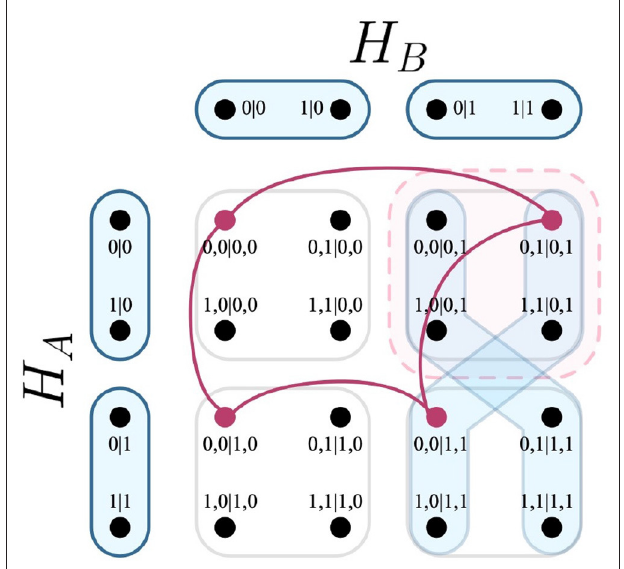
FIGURE 7 | Intersection of a relation, two edges of the F-R product, and a (cid:26) NC C (deep red) intersects one edge of clique. As shown above, the clique c ∈ the F-R product (light blue) twice, and the other not once. Integrated into the expression |{ c ∩ e }| − 1, both edges produce the values + 1 and − 1,